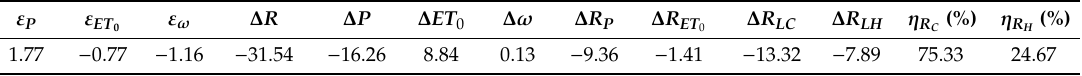
Table 3. The attribute analysis of runo ff change in the source area of the Yellow